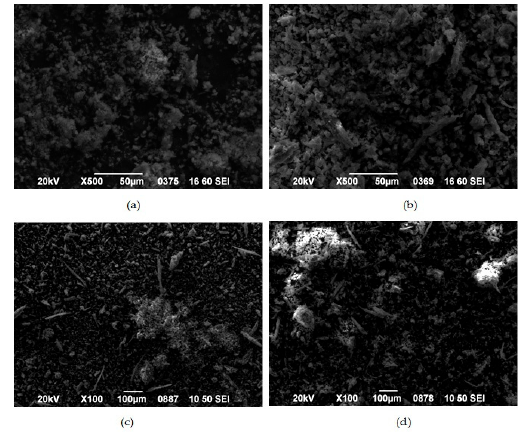
Figure 4. Morphology of β -CD complexes containing: ( a ) 5%; ( b ) 10%; ( c ) 15%; and ( d ) 20 wt % VRCZ.